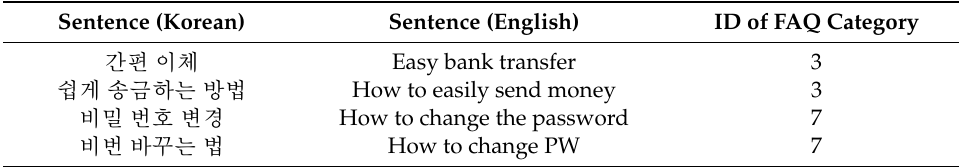
Table 1. Sample of the FAQ